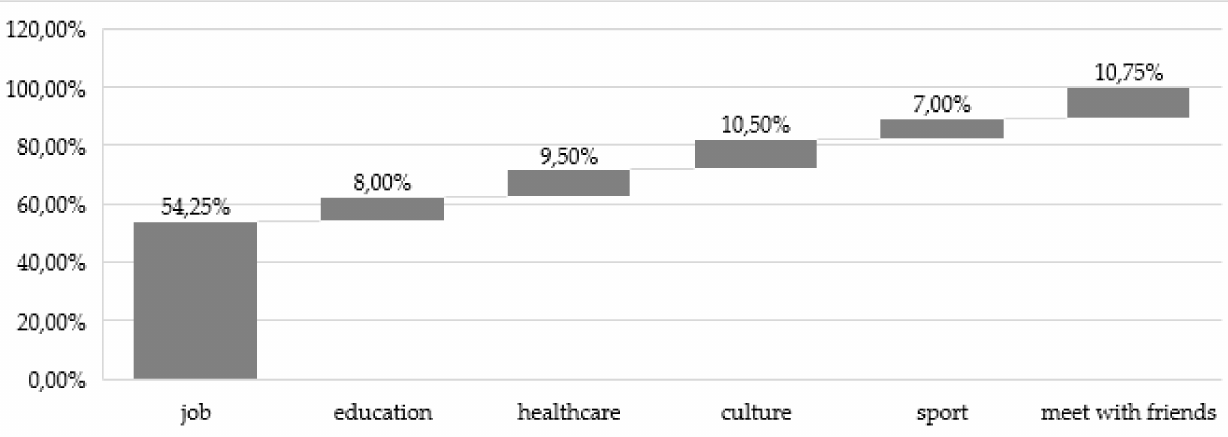
Figure 9. The most common